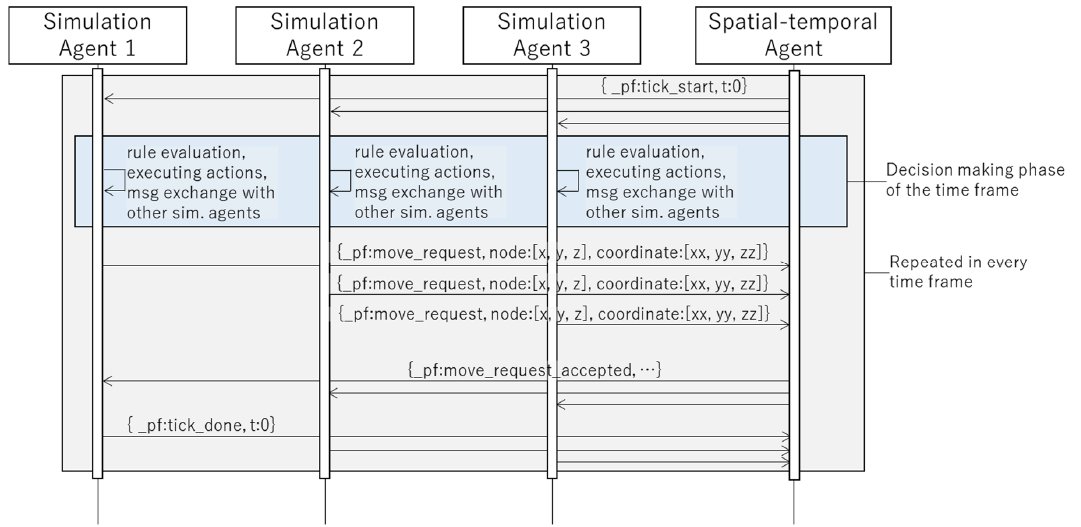
Figure 6. Overview of message exchange sequence among simulation agents and spatial-temporal Figure6. agent.